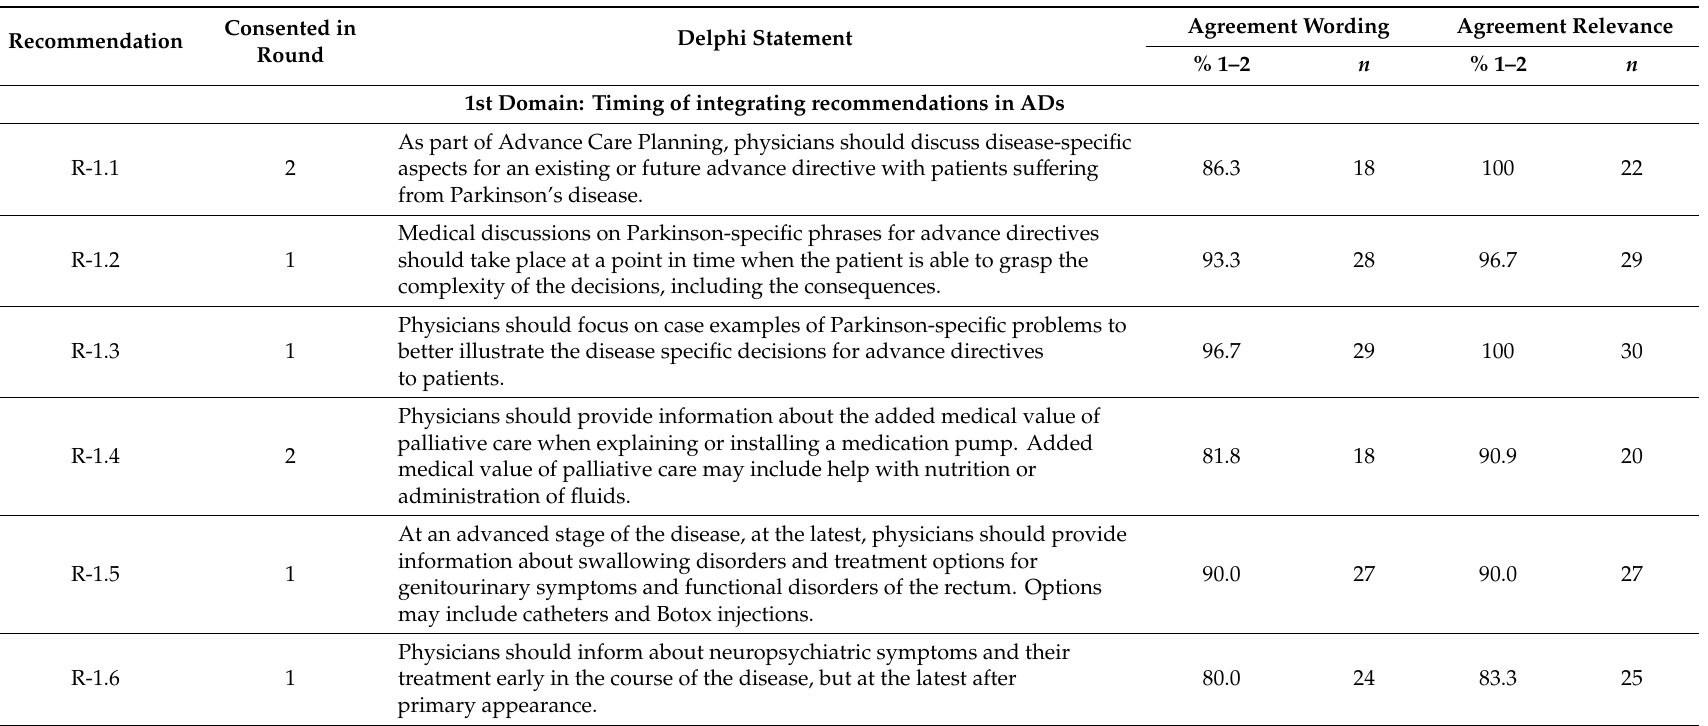
Table 3. Level of agreement on wording and relevance for Delphi